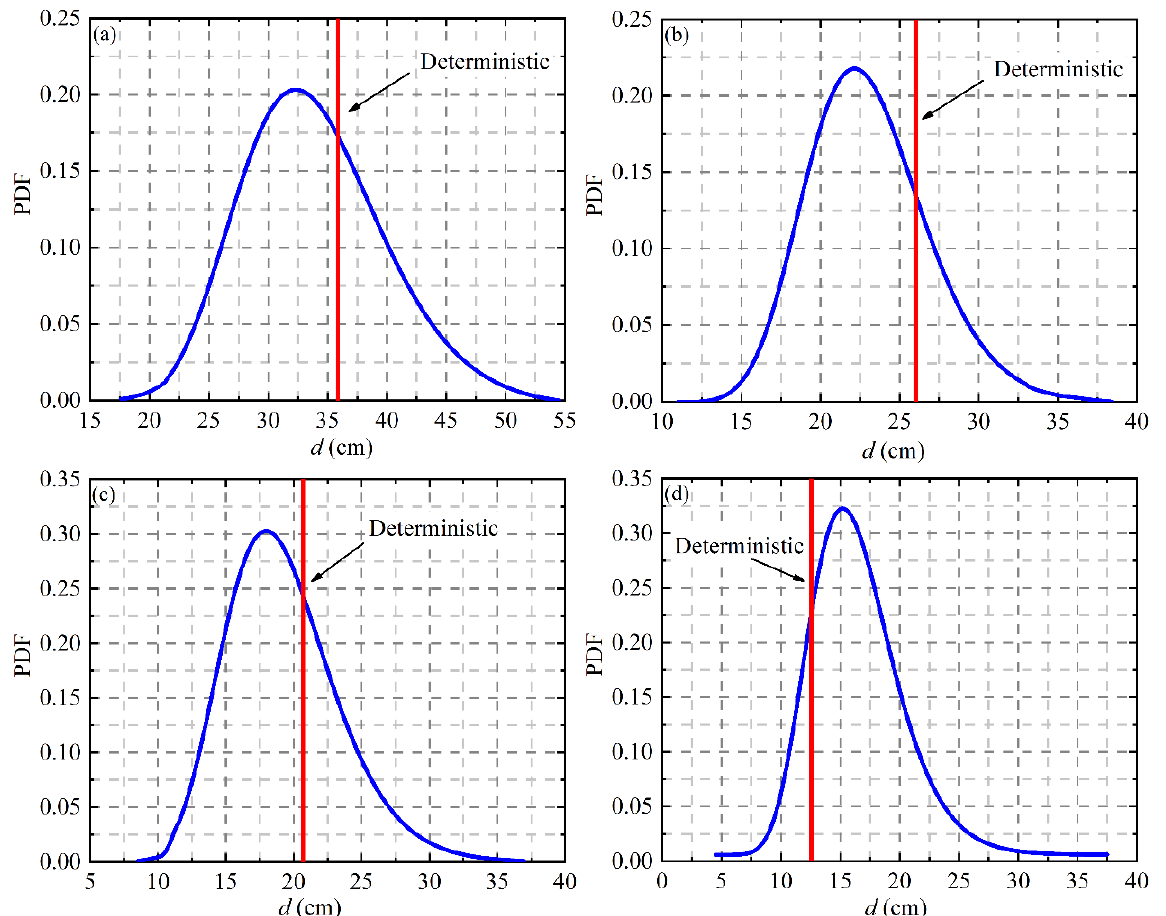
Figure 18. PDF of the peak value of vertical surface displacement at different embedment depths: